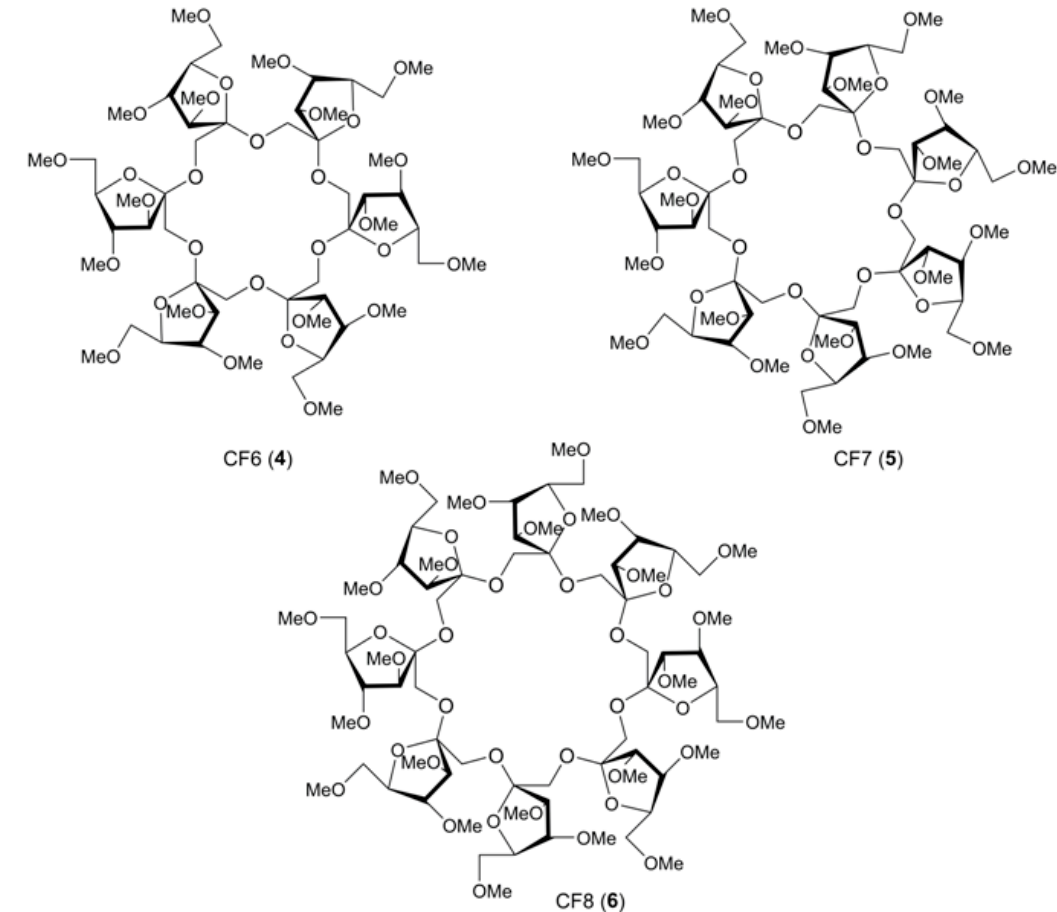
Figure 3. Structural formulas of cyclofructans CF6 ( 4 ), CF7 ( 5 ), and CF8 ( 6 ).